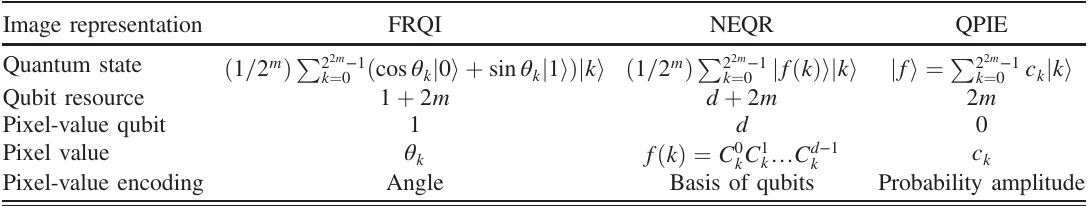
Þ with d -bit depth (for the case M ¼ L ¼ 2 m i;j M × L